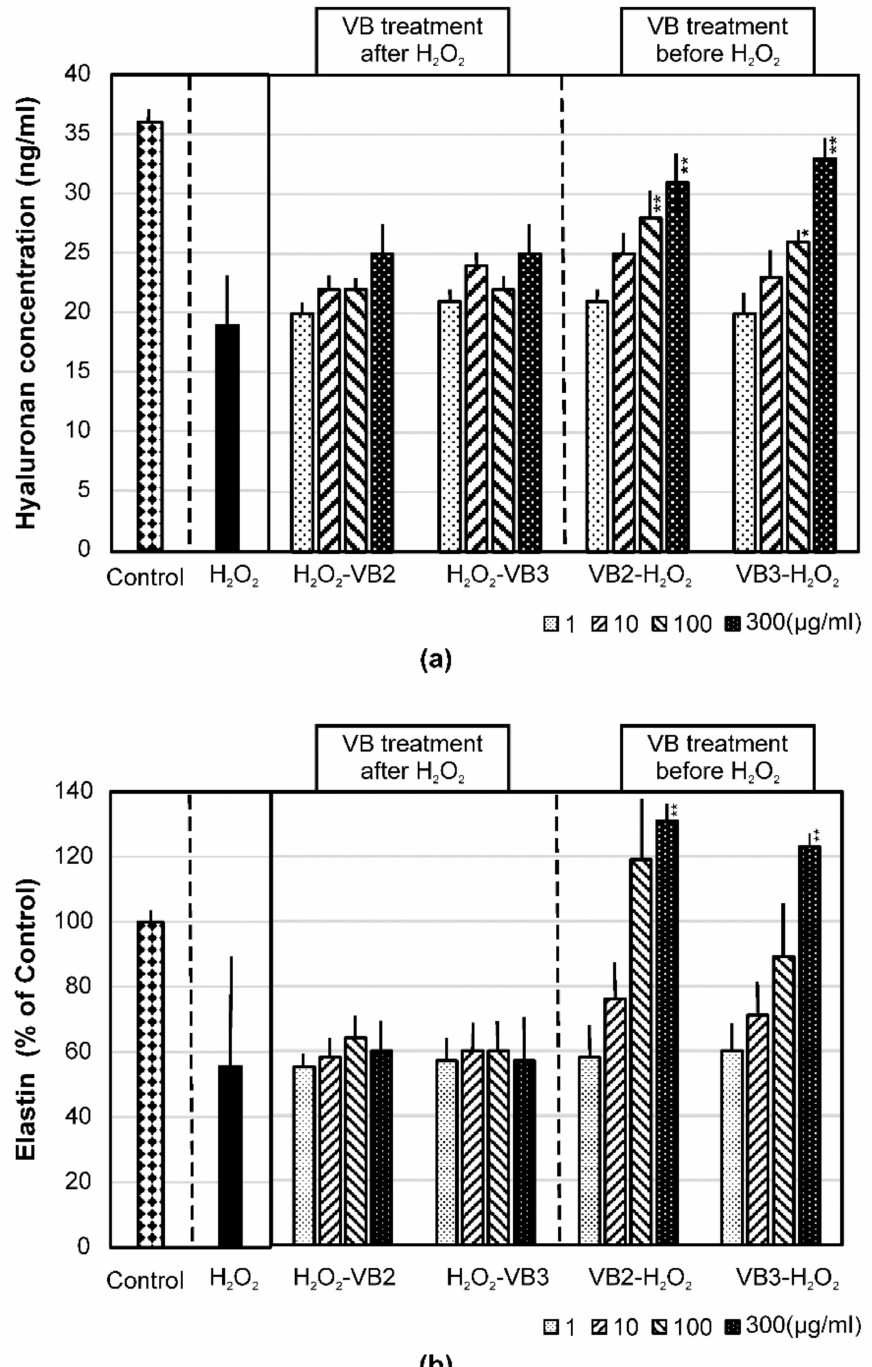
Figure 7. Effects of VBs on the production of hyaluronan and elastin in NHDF treated with H 2 O 2 . To evaluate the therapeutic effects of VBs on oxidative stress, NHDF were treated with 0.2 mM H 2 O 2 for 2 h, washed with PBS, and continued to be cultured with various concentrations of VBs for 4 h. In another experiment, cells were initially treated with various concentrations of VBs for 4 h, washed, and then cultured with 0.2 mM H 2 O 2 for 2 h to monitor prophylactic effects. ( a ); Following the treatments with VBs and H 2 O 2 , the concentration of hyaluronan in the culture supernatant was measured. ( b ); VB- and H 2 O 2 -treated cells were lysed in lysis buffer and the amount of elastin was measured. Data were expressed as a percentage of that in the control. * p < 0.01, ** p <